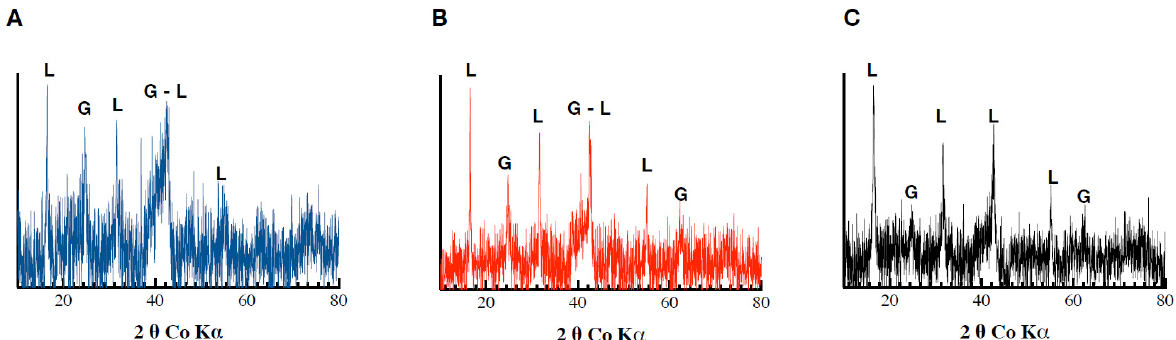
Figure 2. Diffractograms obtained following Co-XRD measurements of the ( A ) Fh, ( B ) Fh_Pb(0.02), and ( C ) Fh_Pb(0.05) systems after the RP1 with Shewanella oneidensis MR-1.